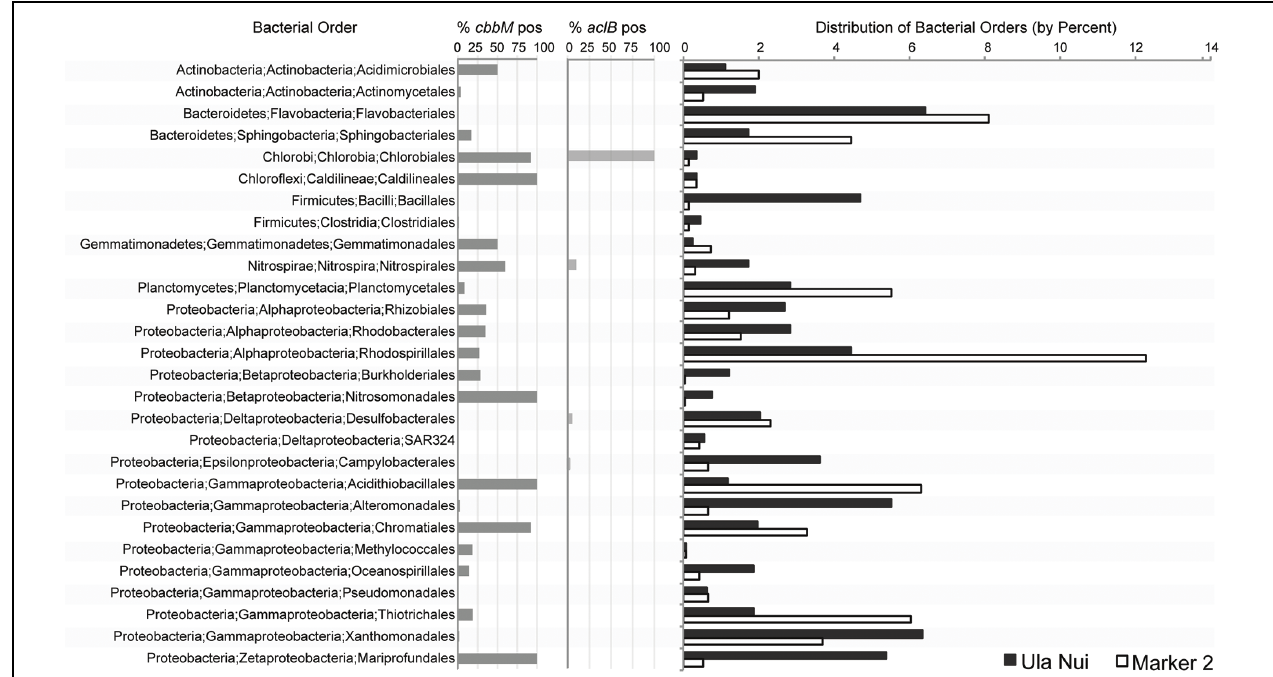
FIGURE 5 | Percent abundance of bacterial orders detected by Ion Torrent sequencing of the V6 region of the 16S rRNA gene from environmental DNA extracts from the Ula Nui and Marker 2 Loihi seafloor basalts versus the percent abundance of publically available genomes from the same orders with evidence of cbbM or aclB genes. Percent abundance of bacterial orders has been published previously (Jacobsen Meyers et al., 2014) and is used here with